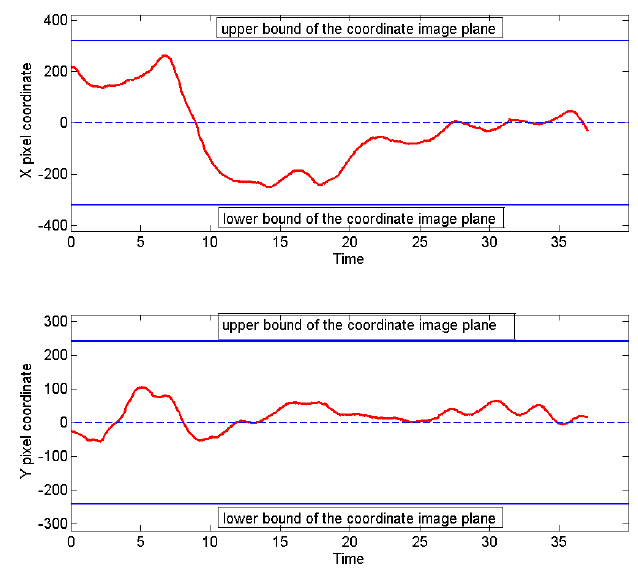
Figure 8. Image coordinates of the visual target center during the experiment.